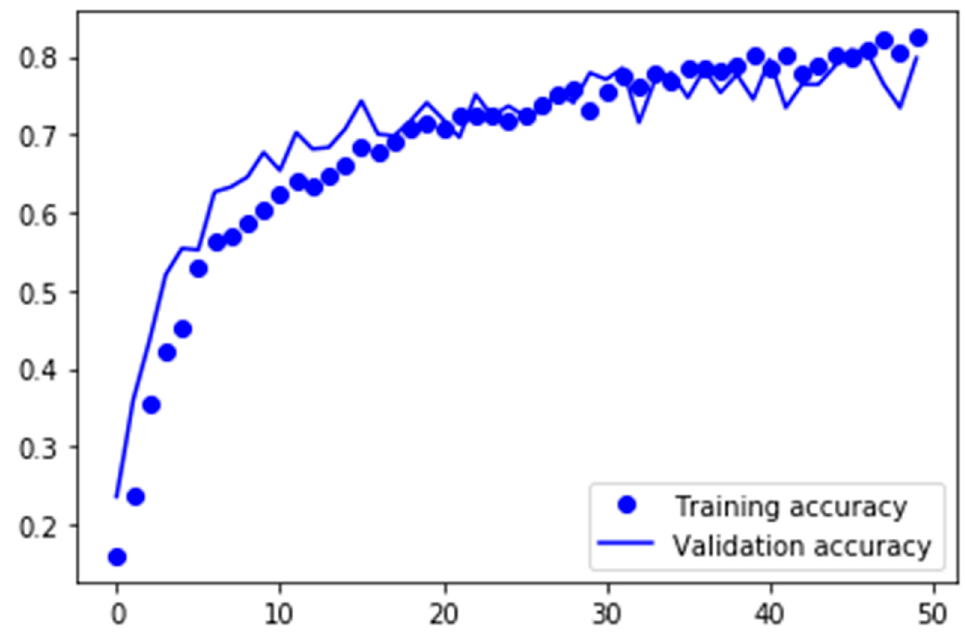
Figure 14. Training and validation accuracy with data preprocessing, trained over 50 epochs.